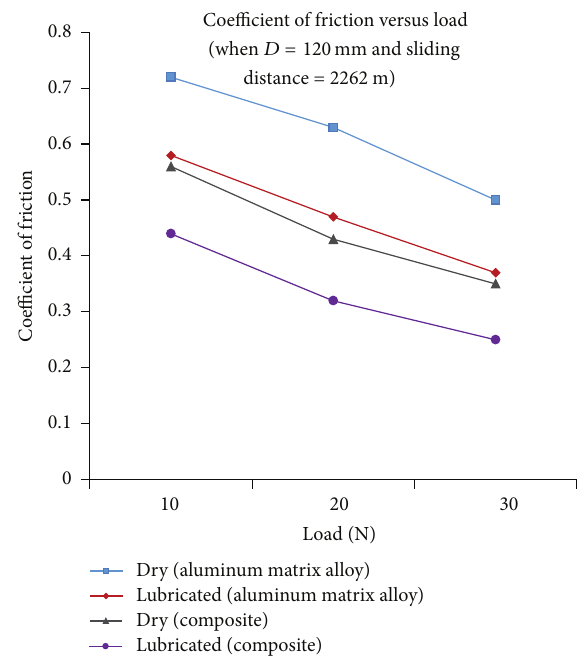
Figure 3: Variation of COF at 𝑉 = 3.77